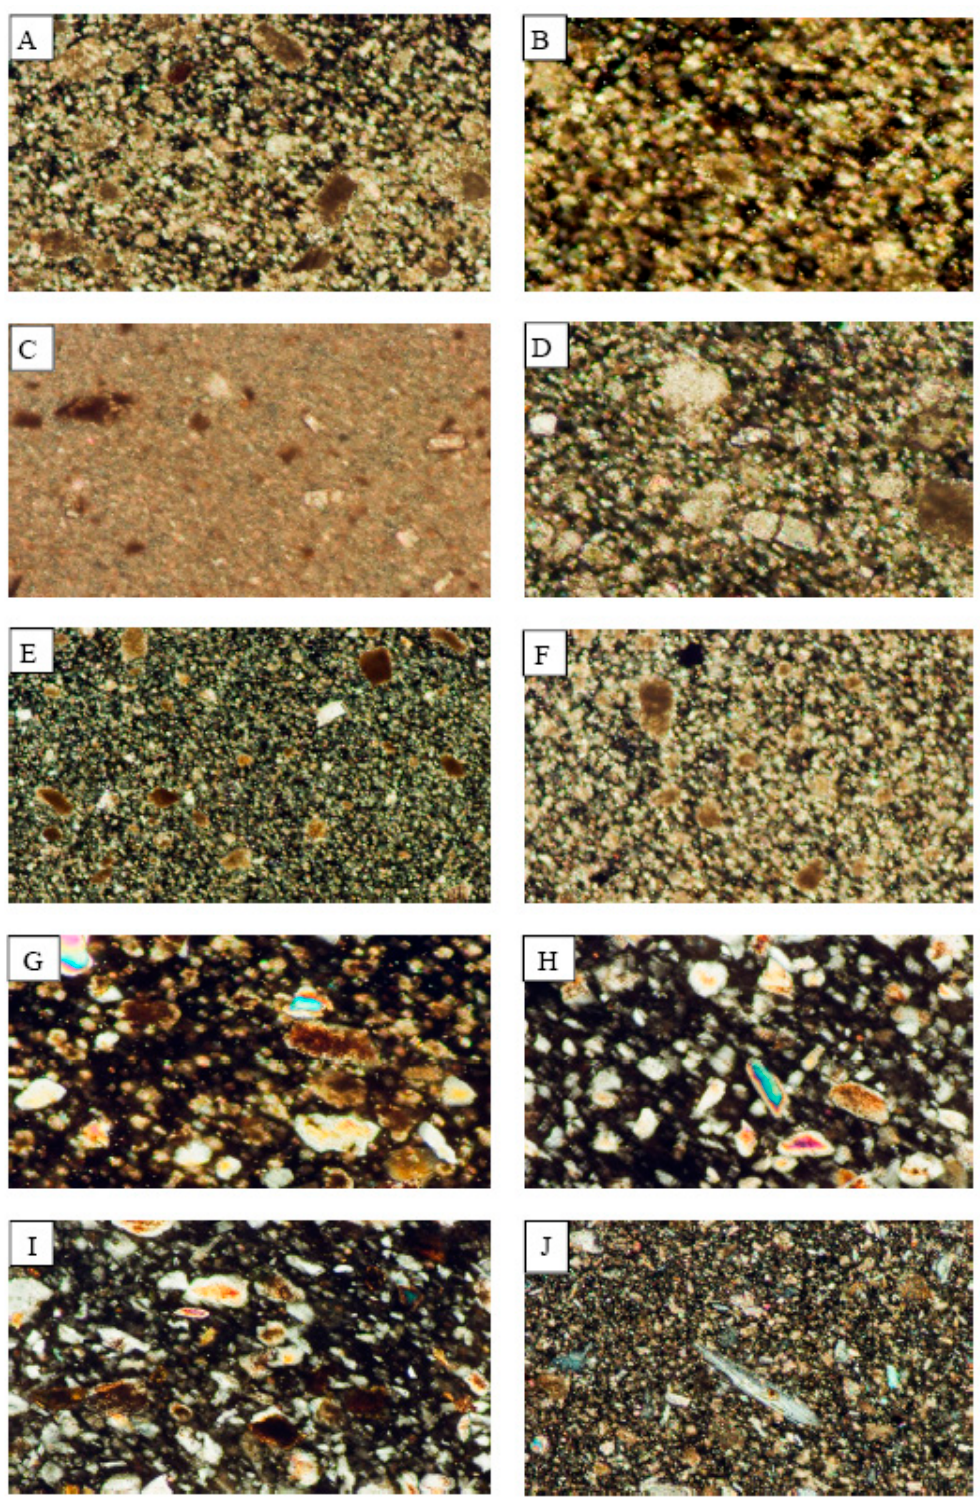
Figure 3. Photomicrographs showing the mineralogical composition of the rocks which are processed in the industrial sites of the study area. ( A ) Fass Galala; ( B ) Plain Galala; ( C ) Treasta; ( D ) Local Selvia; ( E ) Golden Sinai; ( F ) limestone; ( G ) Hashmi stone; ( H ) Red Royal granite; ( I ) Gandola granite; ( J ) Indian Green marble.